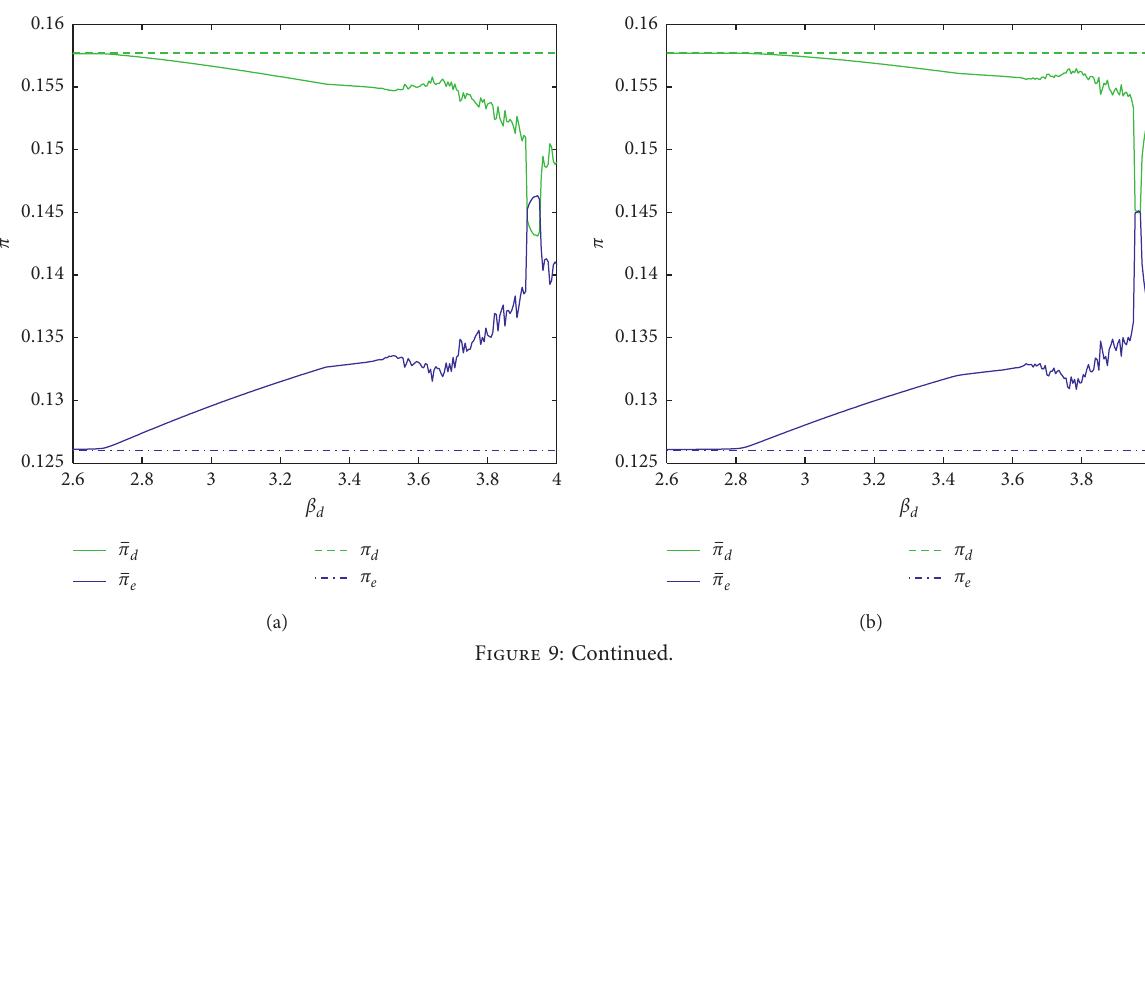
q e (red dot) and d (blue dot) corresponding to Figure